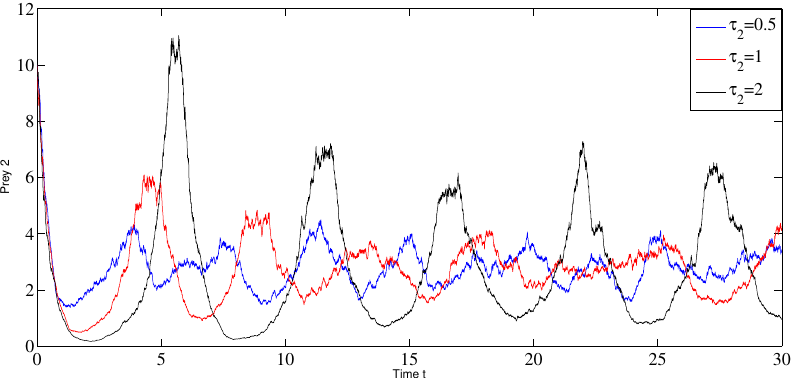
Figure 7. The behavior of the prey 2 population for different values of τ 2 .